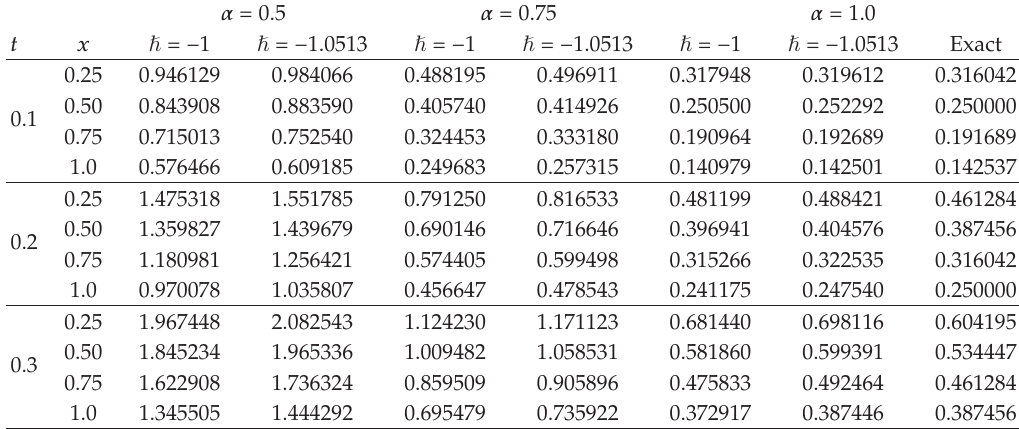
Table 3: Approximate solution of (cid:3) 4.30 (cid:4) for some values of α using the 3-term HAM approximation, φ with (cid:2) (cid:8) − 1 and − 1 .